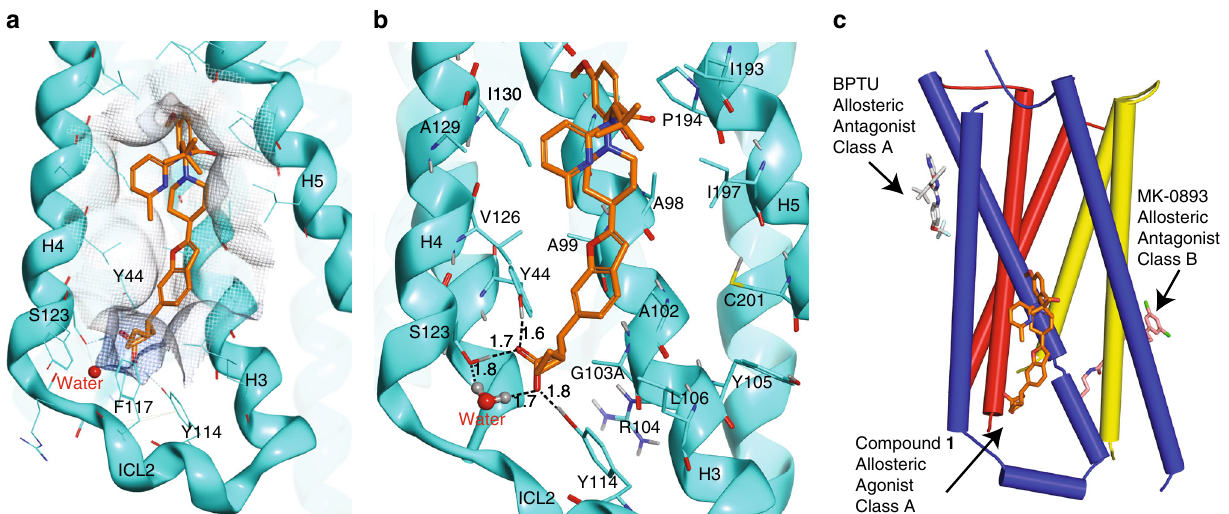
Fig. 5 Binding interaction of compound 1 . a In silver mesh is an “ interaction surface ” of site A2, indicating that the ligand is within optimal van der Waals (vdW) contact distance when touching the surface (like the seven-position of the benzofuran). Receptor is colored in cyan, and compound 1 in orange. Ribbon represents the transmembrane helices. b A more detailed view of the binding site. Hydrogen bonds are represented as dotted lines. Distances shown are between oxygen and hydrogen. Hydrogens were computationally modeled into the structure to illustrate hydrogen bond donors and acceptors. Receptor side chains are colored by atom type (carbon in cyan, oxygen in red, nitrogen in blue, hydrogen in gray, and sulfur in yellow). compound 1 is illustrated as sticks, colored by atom type with carbon in orange. Transmembrane helices H3, H4, H5 and ICL2 are labeled. Note that G103A is one of the stabilizing mutations. A103 is nearby, and its methyl group sidechain forms a vdW contact with the carbon alpha to the acidic group in compound 1 . c Schematic overview of identi fi ed GPCR ligand binding positions outside the helical bundles. Transmembrane helices H1 and H2 are colored in red; H3, H4, and H5 are colored in purple; H6 and H7 are colored in yellow. Figures were prepared using Molecular Operating Environment (MOE) 35 and